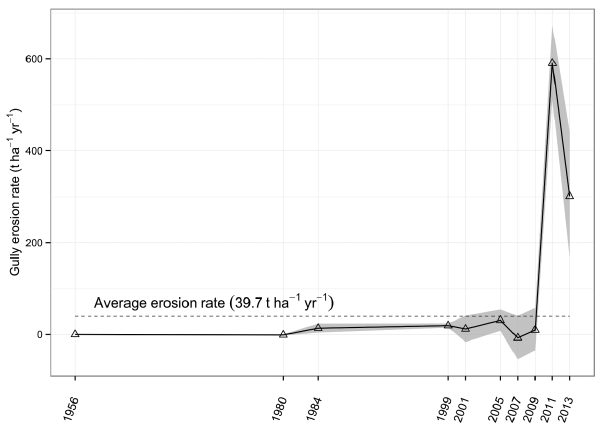
Figure 15. Gully erosion rate in tha − 1 yr − 1 calculated by the Monte Carlo simulation method, and average erosion rate in the period 1956–2013. The grey area represents the 90% uncertainty